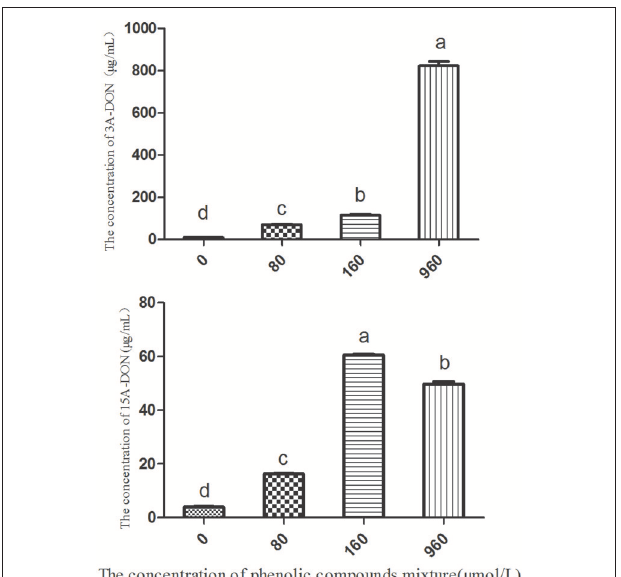
FIGURE 5 | The effects of the phenolic compound mixture on the toxin production of T. helicus . Columns with different letters are statistically different (LSD-test, p < 0.05 ).